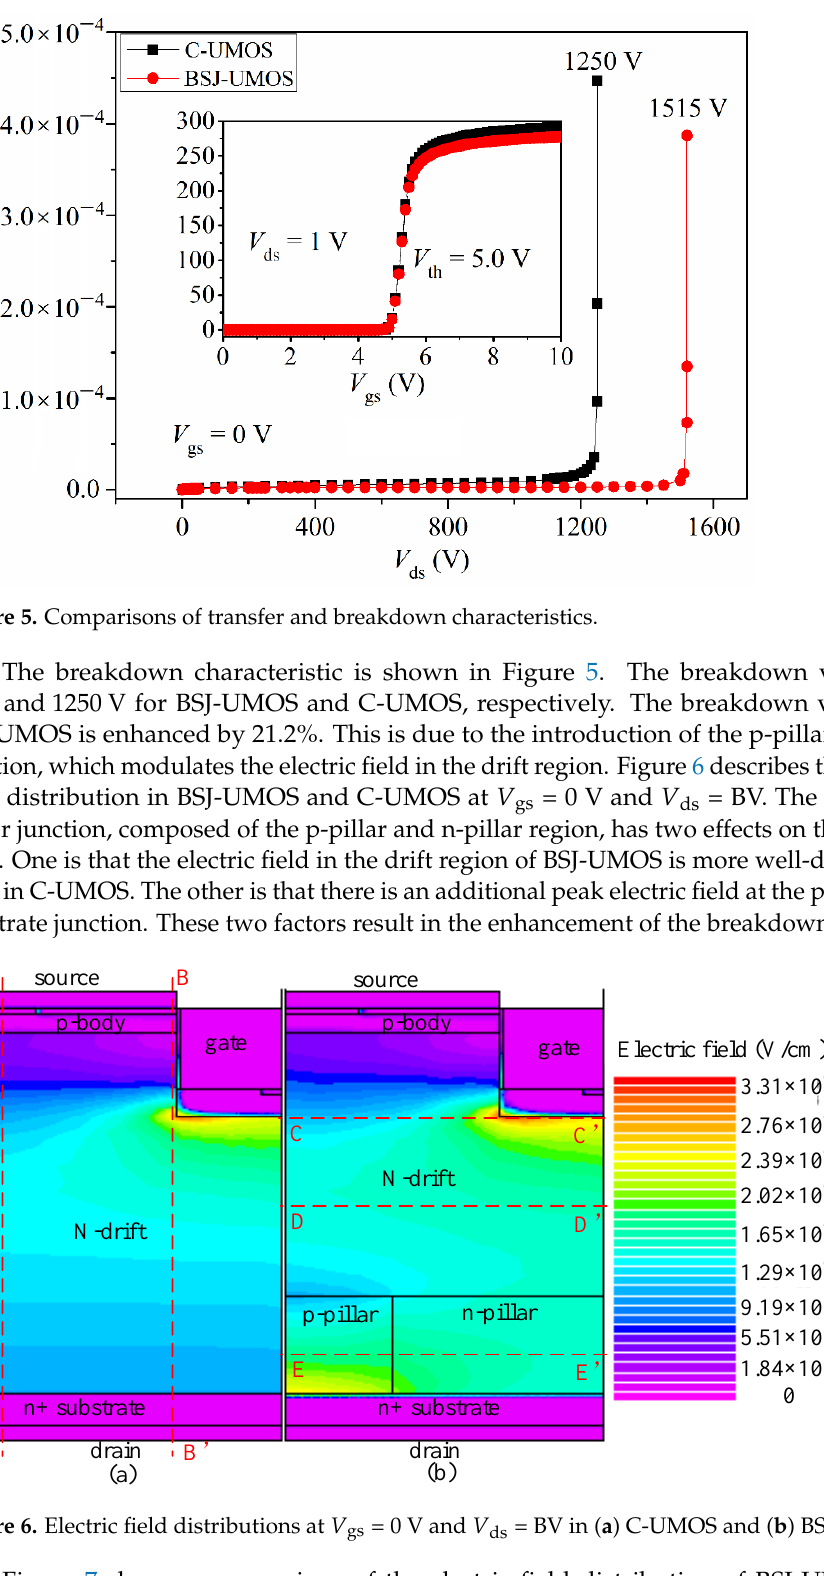
Figure 4. Distributions of current flowlines at J ds = 100 A/cm 2 in ( a ) C-UMOS and ( b ) BSJ-UMOS